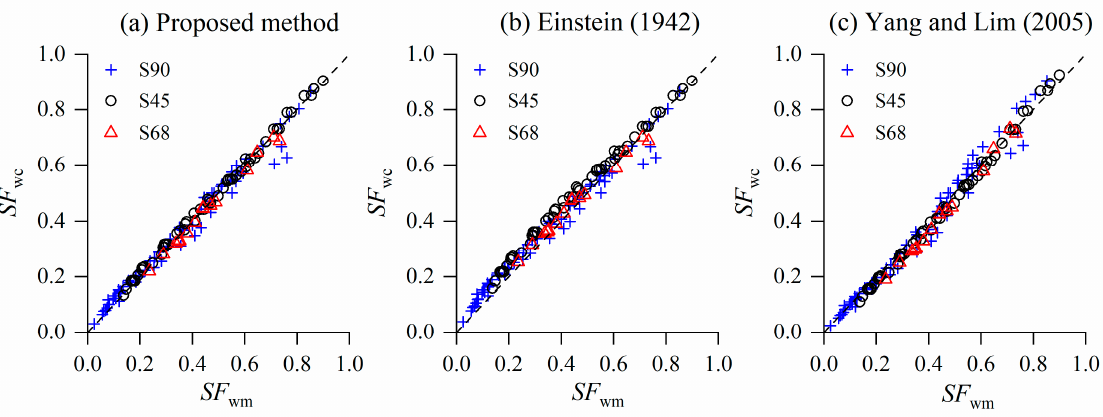
Figure 3. Comparisons between the proposed method, Einstein’s method [19], and YLM’s method [22].